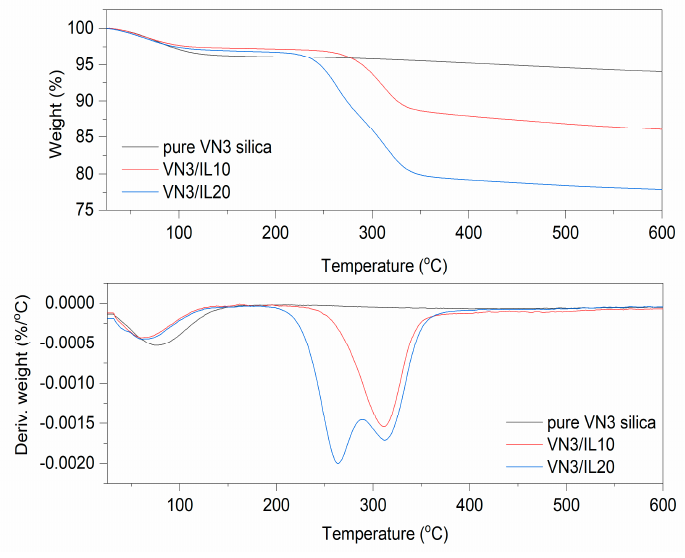
Figure 2. TG and Differential Thermogravimetric (DTG) curves for pure and DmiBr-modified silica VN3. Table 3. DmiBr content in modified fillers and e ffi ciencies of